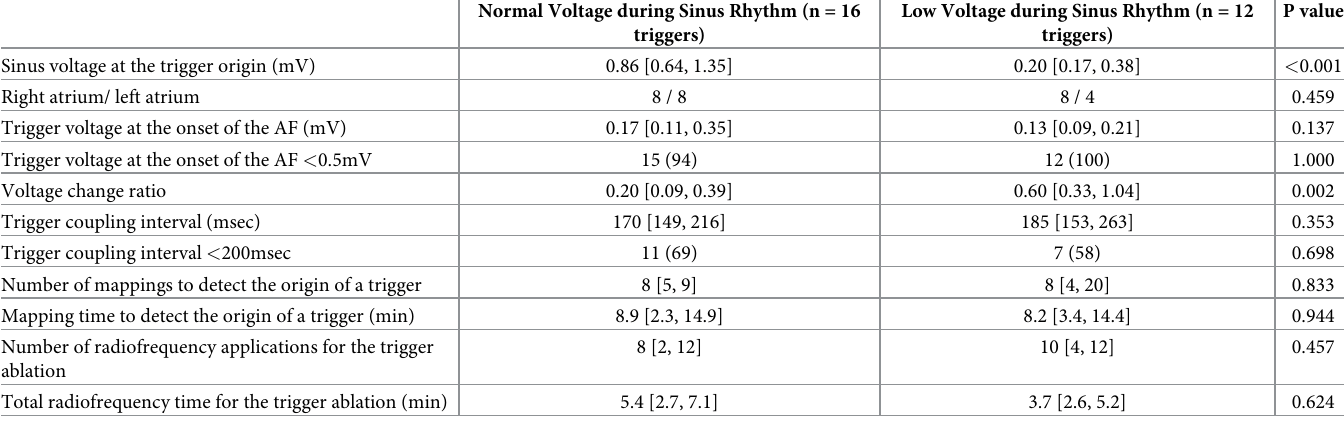
Table 3. Differences in the electrophysiological characteristics between a normal voltage and low voltage during sinus